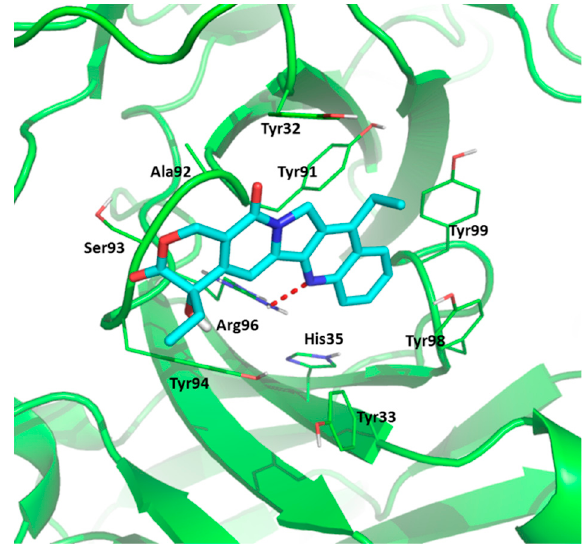
Figure 4. Molecular docking plots of human IgG with 7-ethylcamptothecin. Only residues around 6 Å of the drug are displayed. Hydrogen bonding formation is indicated by dash lines.